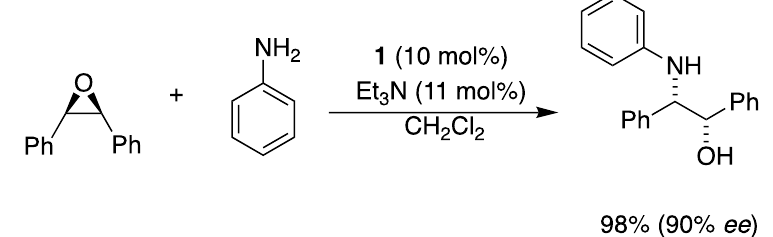
Scheme 9. The asymmetric aminolysis of meso -stilbene oxide catalyzed by in situ formed